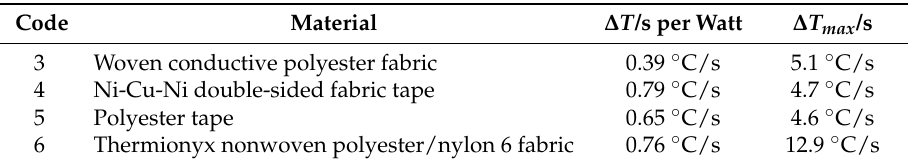
Table 7. Rate of Heating and Power